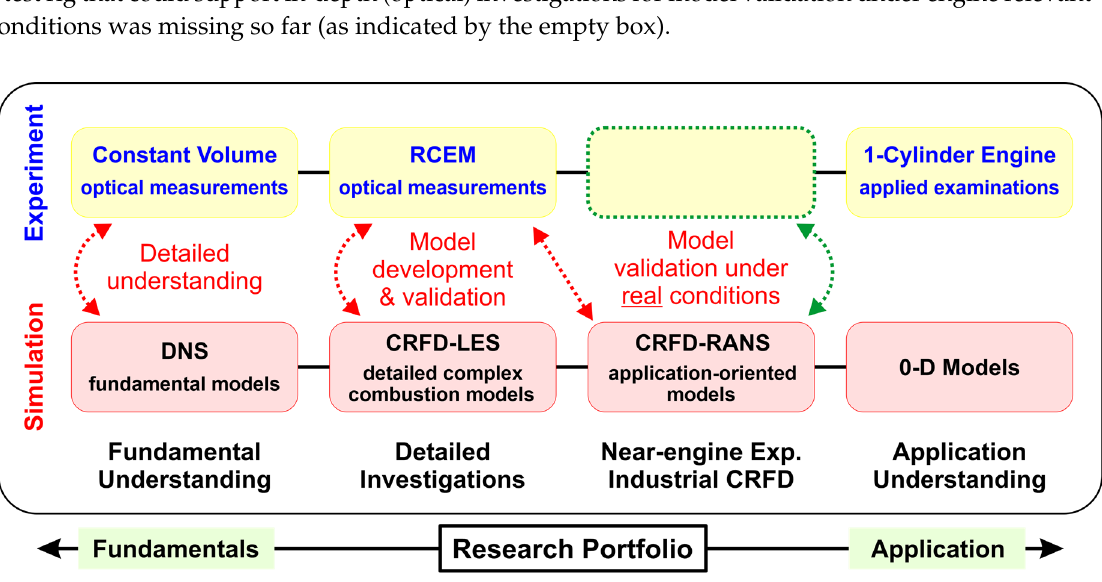
Figure 1. Research portfolio of the involved institutions related to the field of combustion engines. The empty box indicates the missing part of the experimental side.